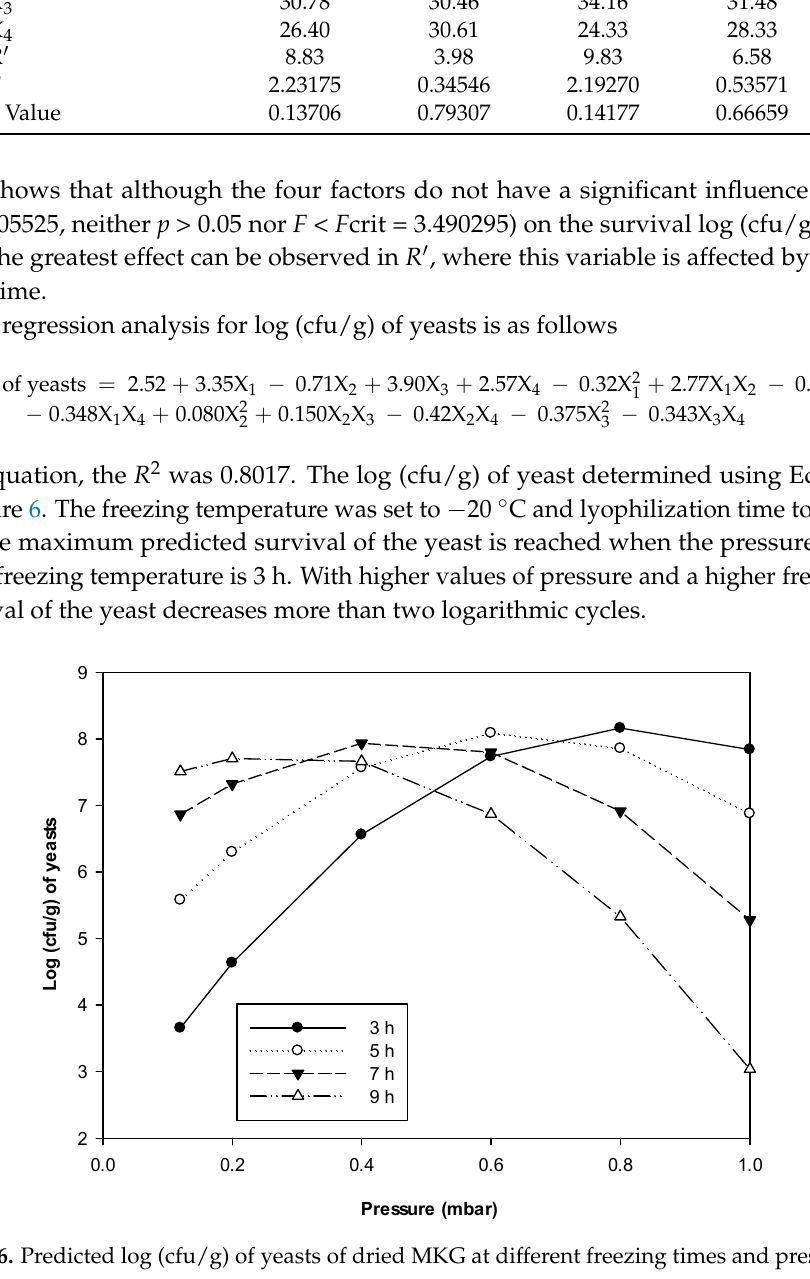
highest value of 8.67 log (cfu/g) for yeasts is less than 0.5 cycle logarithmic of the fresh sample before 282 drying (8.90 log (cfu/g) of yeasts). This was obtained at freezing times of 3 to 7 h, freezing temperatures 283 of –20 to –60 °C, pressure of 0.6 mbar, and lyophilization time of 15 to 20 h. The relative error differences 284 between the experimental and predicted log (cfu/g) of yeasts were 14.24 and 7.36% for tests No. 3 and 9, 285 respectively. Freeze-drying had a negative effect on the survival rate of 2.60%; this result is similar to that 286 reported in other studies, which also reported a negative effect, even with the use of cryoprotectants 287 [53,54]. 288